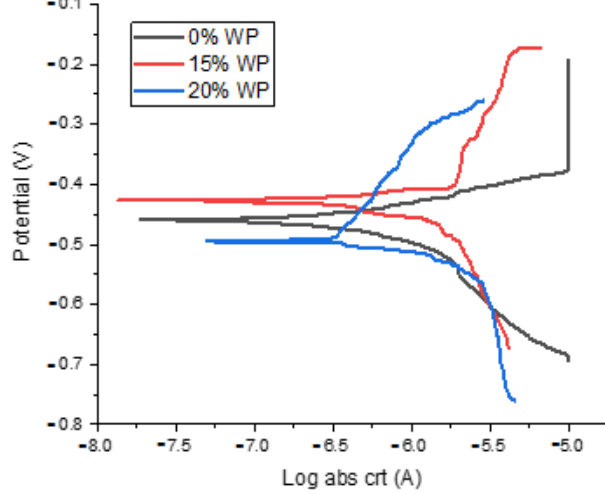
Figure 4. Tafel curve of the composites. Table 4. Potentiodynamic curve (Tafel plots) parameters.